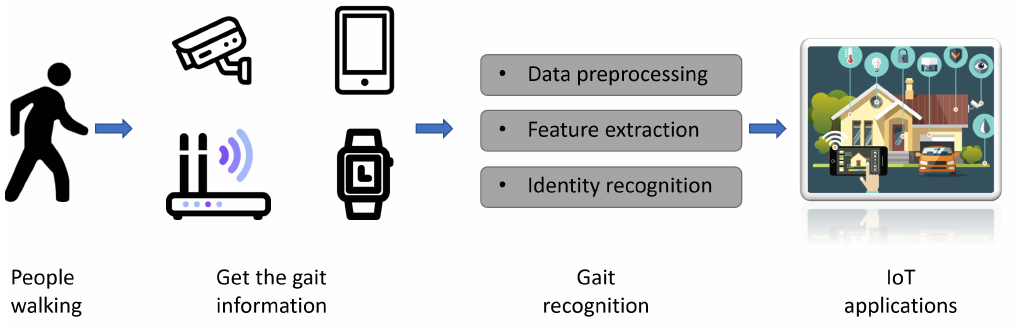
Figure 1. Sketch map of gait